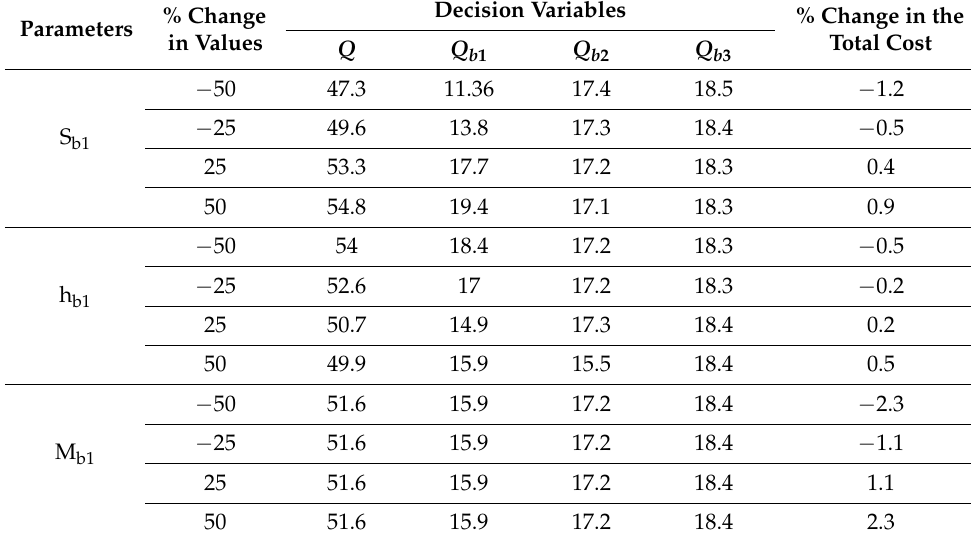
Table 9. Sensitivity analysis of outsourcers’